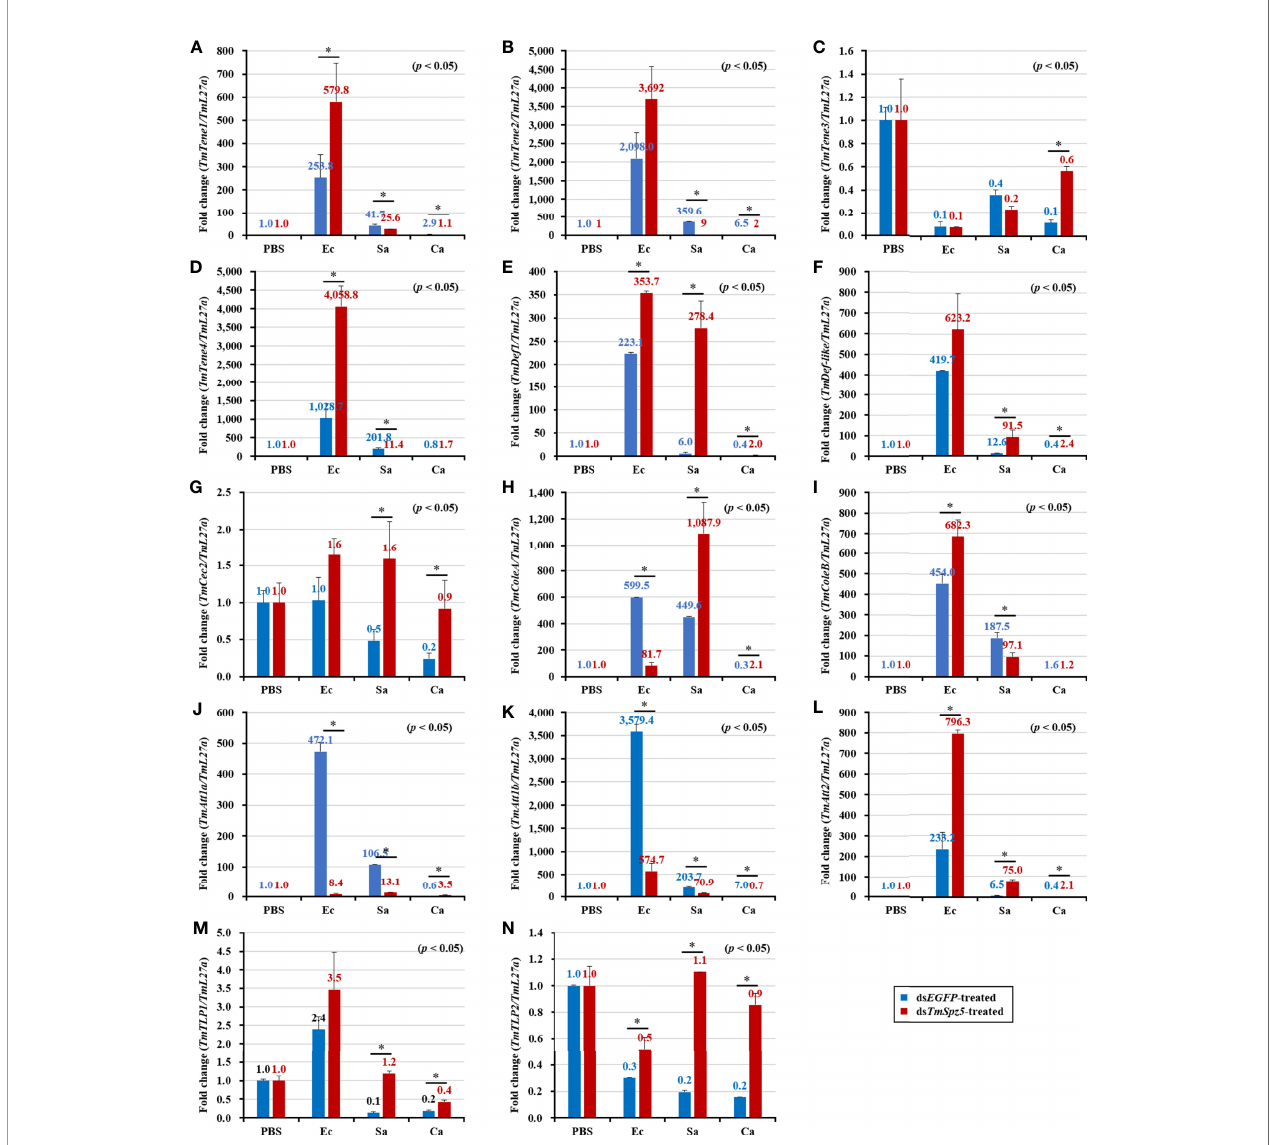
FIGURE 7 | Effect of TmSpz5 gene silencing on antimicrobial peptide (AMP) gene expression levels in the T. molitor gut. Four days after TmSpz5 RNAi treatment, pathogens including E. coli (Ec), S. aureus (Sa), and C. albicans (Ca) and PBS as control were injected. Levels of the AMP genes, including TmTene1 (A) , TmTene2 (B) , TmTene3 (C) , TmTene4 (D) , TmDef (E) , TmDef-like (F) , TmCec2 (G) , TmColeA (H) , TmColeB (I) , TmAtt1a (J) , TmAtt1b (K) , TmAtt2 (L) , TmTLP1 (M) , and TmTLP2 (N) were evaluated by qRT-PCR at 24 h post-microbial injection. ds EGFP was injected as a negative control, and TmL27a expression was evaluated as an internal control. All experiments were performed in triplicate. Asterisks indicate signi fi cant differences between ds TmSpz5 - and ds EGFP -treated groups when compared using Student ’ s t -test ( p <